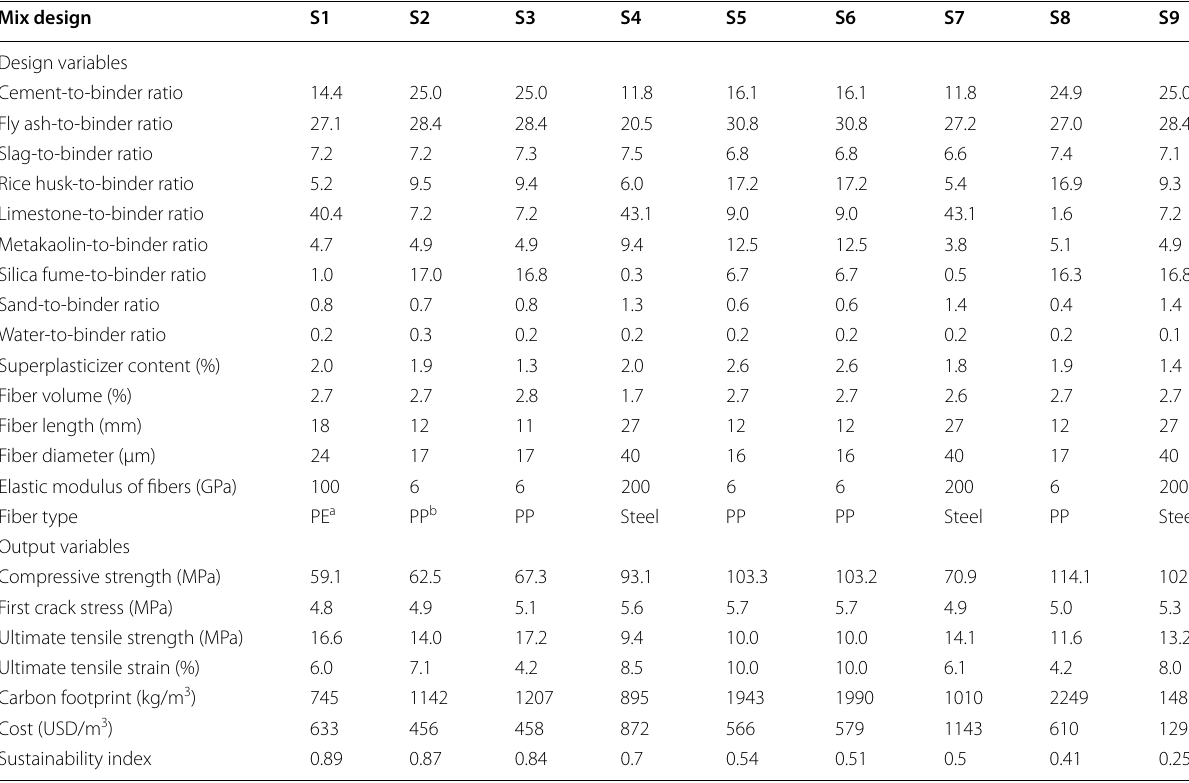
Table 4 Optimal design of HPFRCC